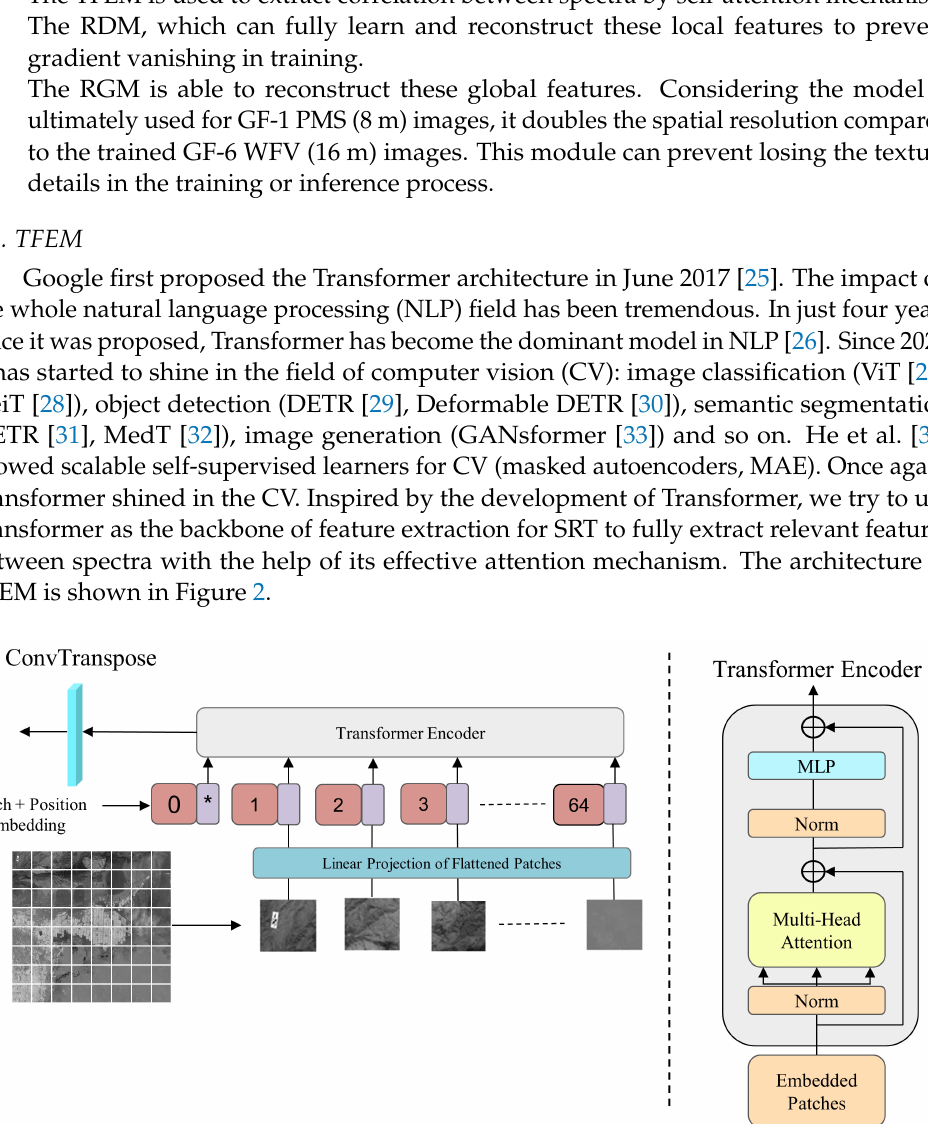
Figure 2. The architecture of TFEM, where the purple blocks are obtained vectors from each linear projection of the flattened patch, and the red blocks are the learnable positional encodings of the corresponding